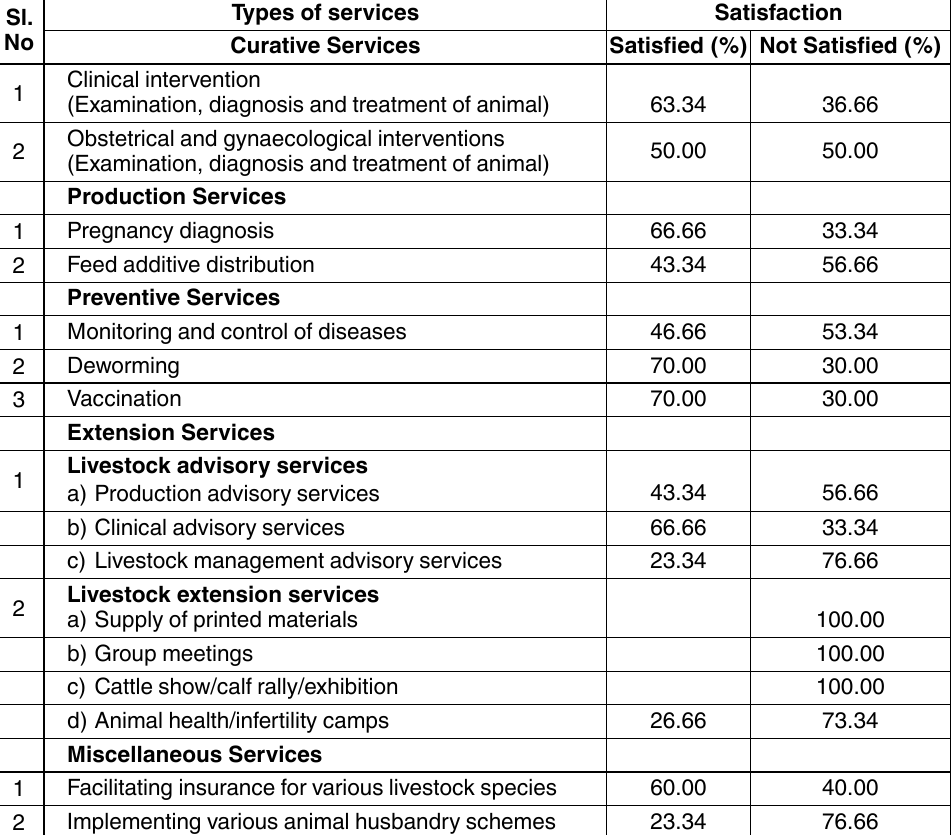
Table 3. Farmers satisfaction towards livestock services provided by dairy cooperatives Sl. No